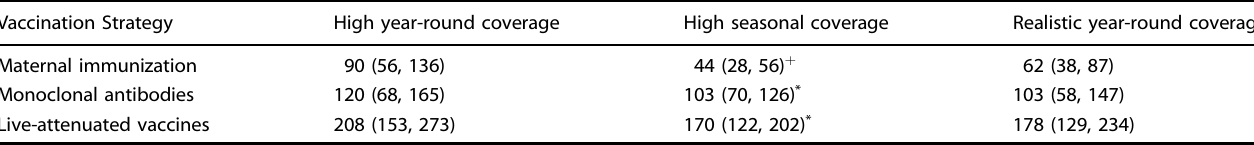
Table 2. Total RSV hospitalizations averted per 100,000 people in children under 5 years of age. Vaccination